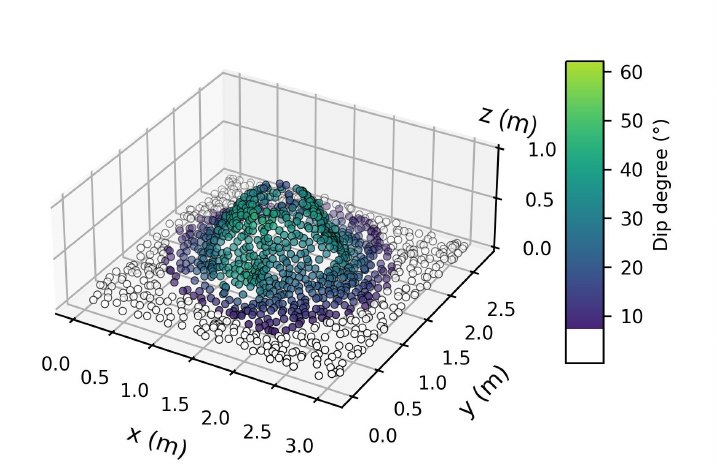
Figure 4. A termite mound in the UAV-LS (HR) point cloud. Points are first filtered based on dip degree; if this value falls outside the interval [7°, 86°], points are rejected. Then, data are clustered, and only point clusters that have more than 50 points are considered. The white points are the rejected points.